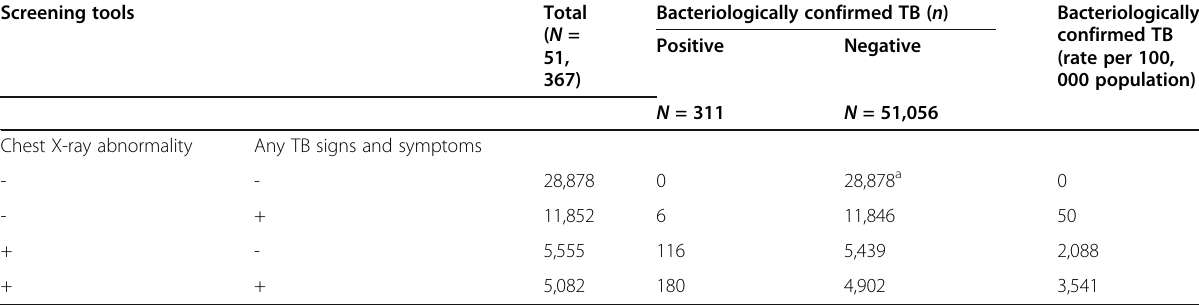
Table 1 Distribution of bacteriologically confirmed TB detected using chest X-ray abnormality and any tuberculosis signs and symptoms as parallel screening tools Screening